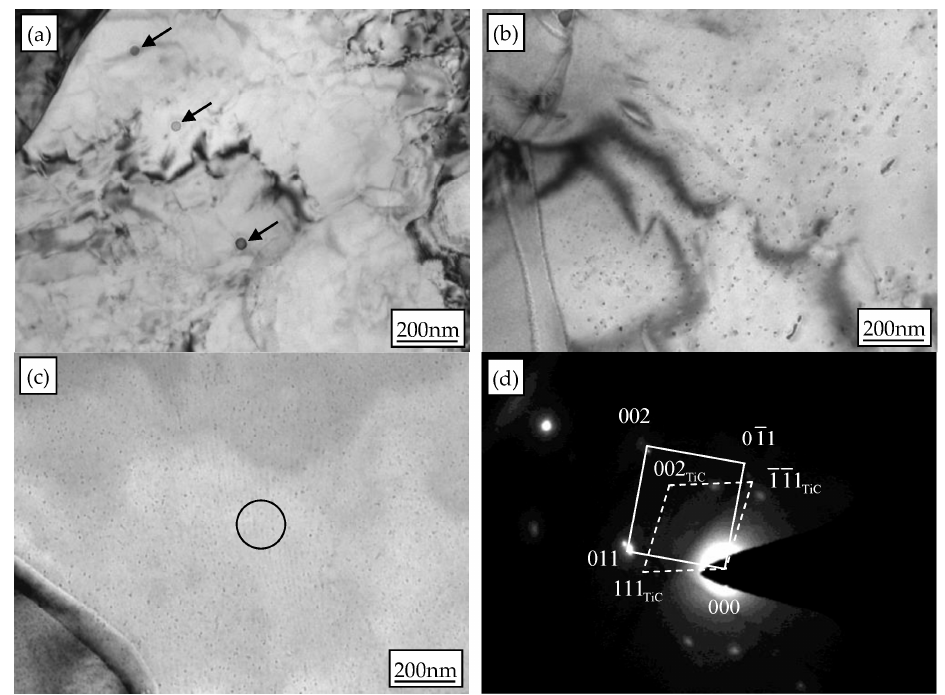
Figure 3. TEM images and SADP of precipitates of experimental steel: ( a ) coiled at 600 °C; ( b ) coiled at 650 °C; ( c ) coiled at 700 °C; ( d ) SADP of interphase precipitates in ( c ).